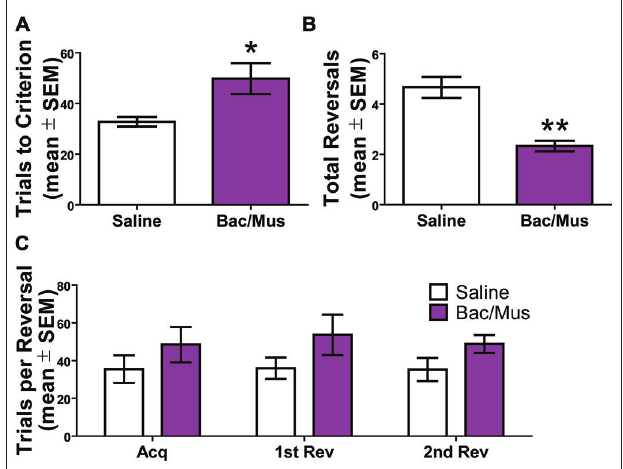
FIGURE 9 | Results of inactivation of the LHb during repeated probabilistic reversal learning. (A) Inactivation of the LHb caused a significant increase on the trials to criterion for the initial acquisition of the test day. (B) There was also a decrease in the total number of completed reversals following LHb inactivation. (C) LHb inactivation resulted in a higher number of trials to criterion across competed discriminations. ∗ p < 0.05, ∗∗ p <